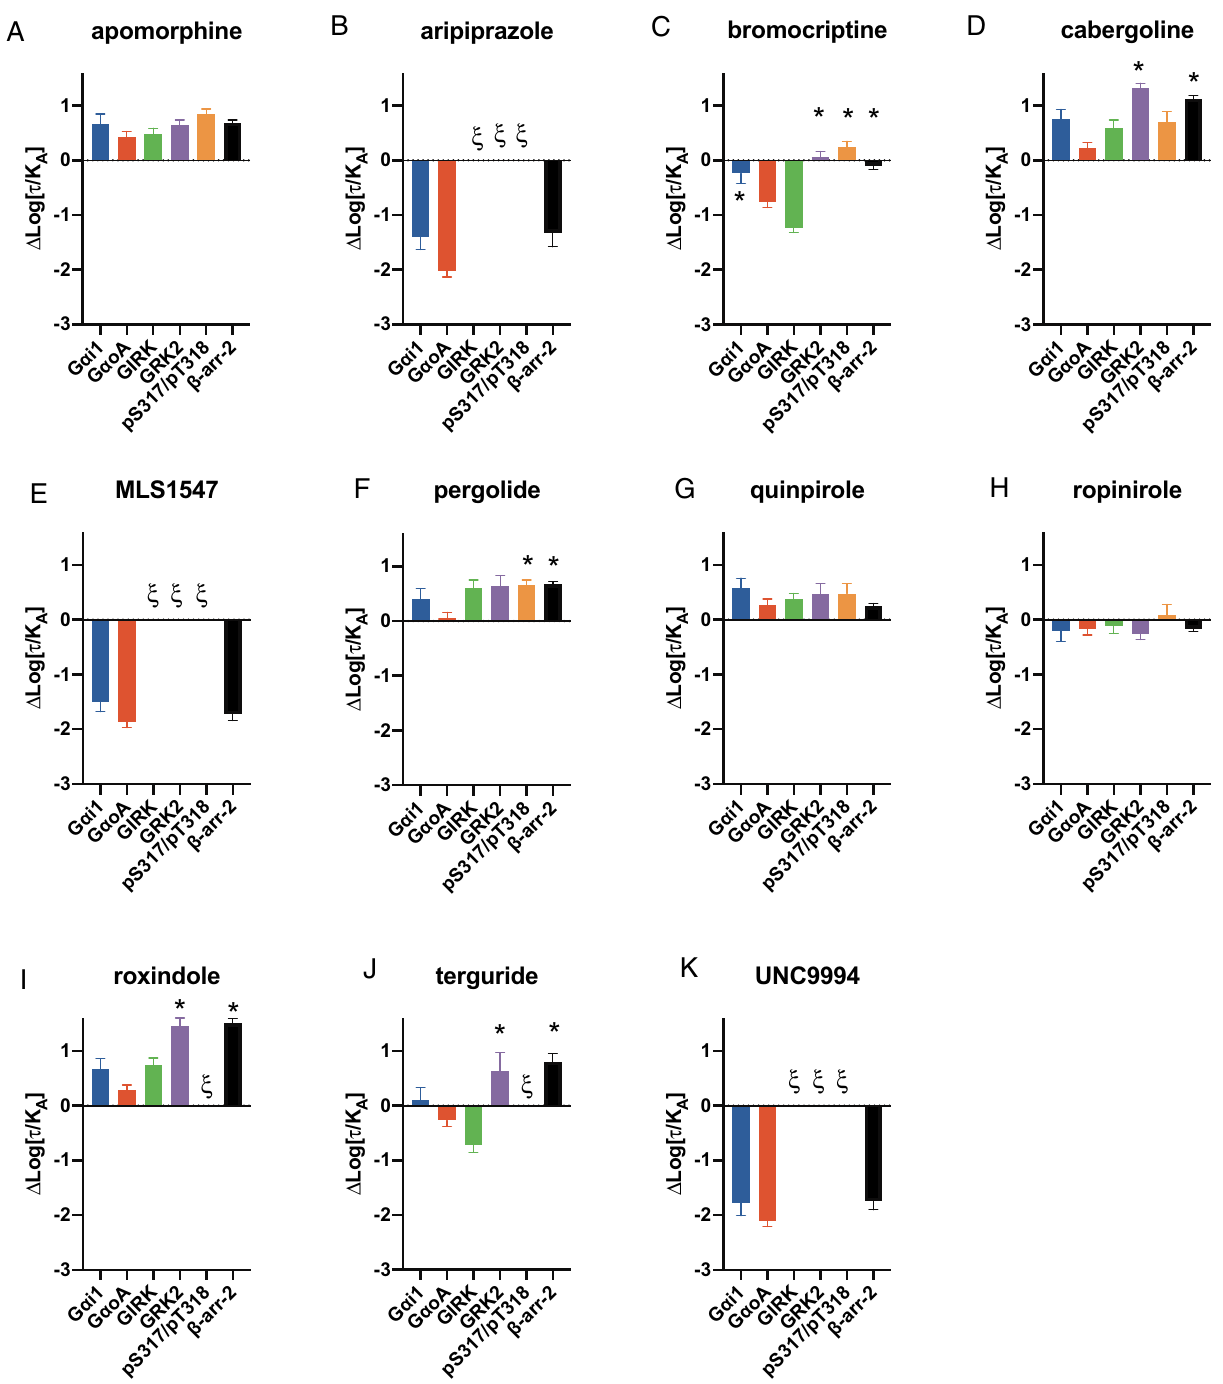
Figure 6. Relative transduction coefficients (ΔLog(τ/K A )) for agonists to activate D 2 R pathways. Concentration–response curves for each endpoint were fit to an operational model of agonism to determine (Log(τ/K A )), this was normalized relative to dopamine to determine the relative transduction coefficient at each pathway (ΔLog(τ/K A ), Supp. Table. 1). Analysis of ΔLog(τ/K A ) values using a one-way ANOVA with Dunnet’s post hoc test revealed significant differences determined for each agonist in the Gαo assay as compared to that obtained in the other signaling and regulatory endpoints. * = P < 0.05. Data presented represents the mean ± S.E.M of at least 3 independent experiments (Supp. Table. 1). ξ denotes instances where agonist responses were not sufficiently robust to allow fitting of the operational